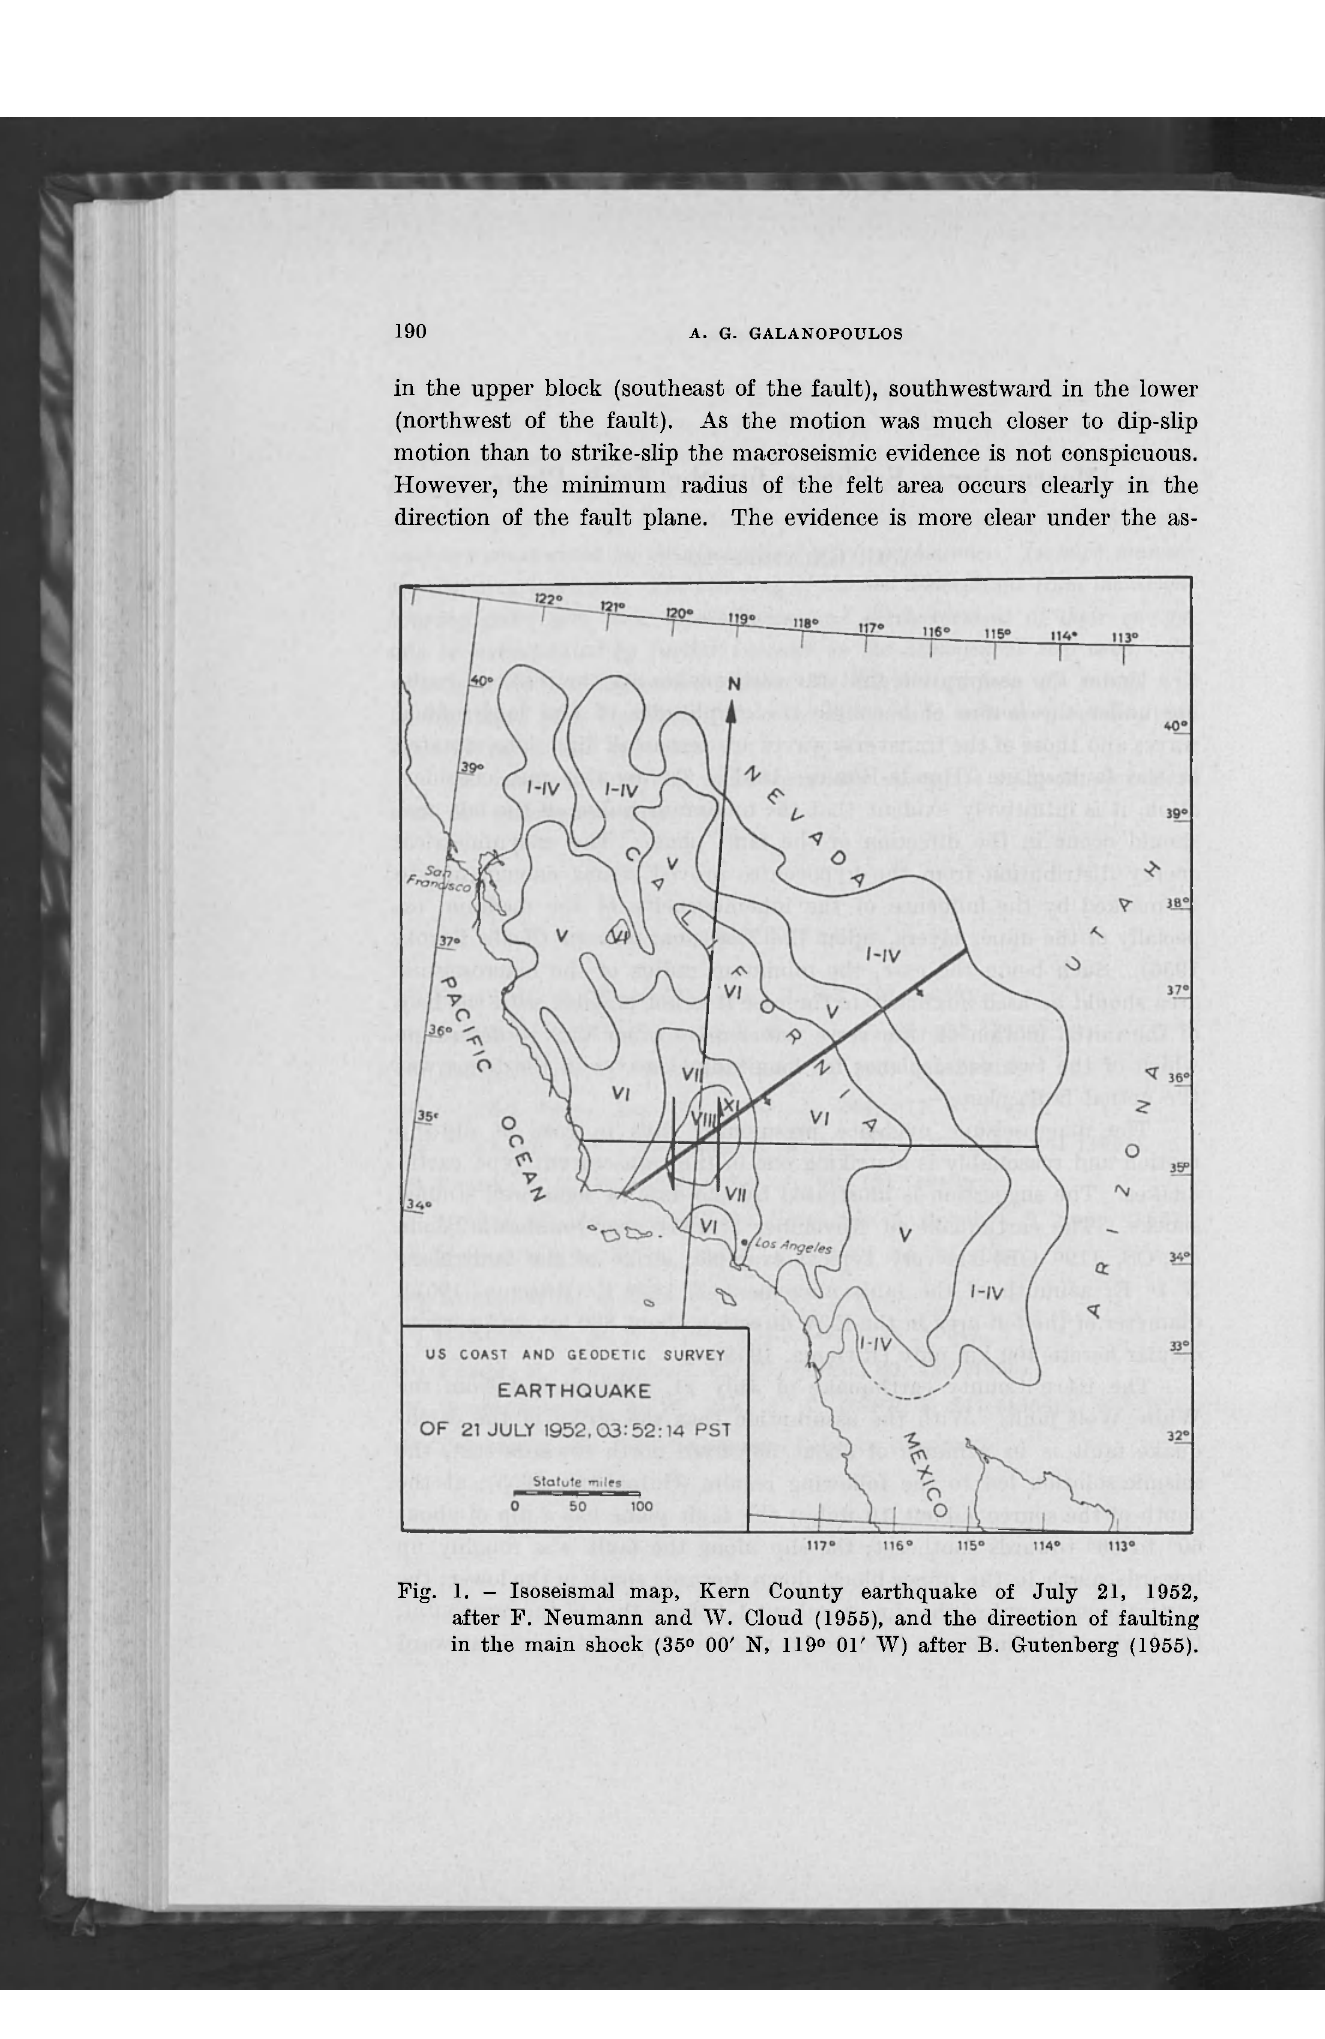
Fig. 1. - Isoseismal map, Kern County earthquake of July 21, 1952, after F. Neumann and. W. Cloud (1955), and tlie direction of faulting in tlie main shock (35° 00' N, 119° 01' W) after B. Gutenberg